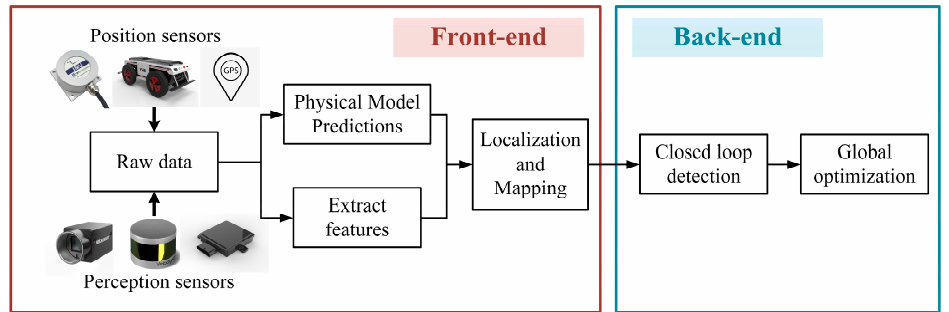
Figure 2. The main components of a SLAM system.